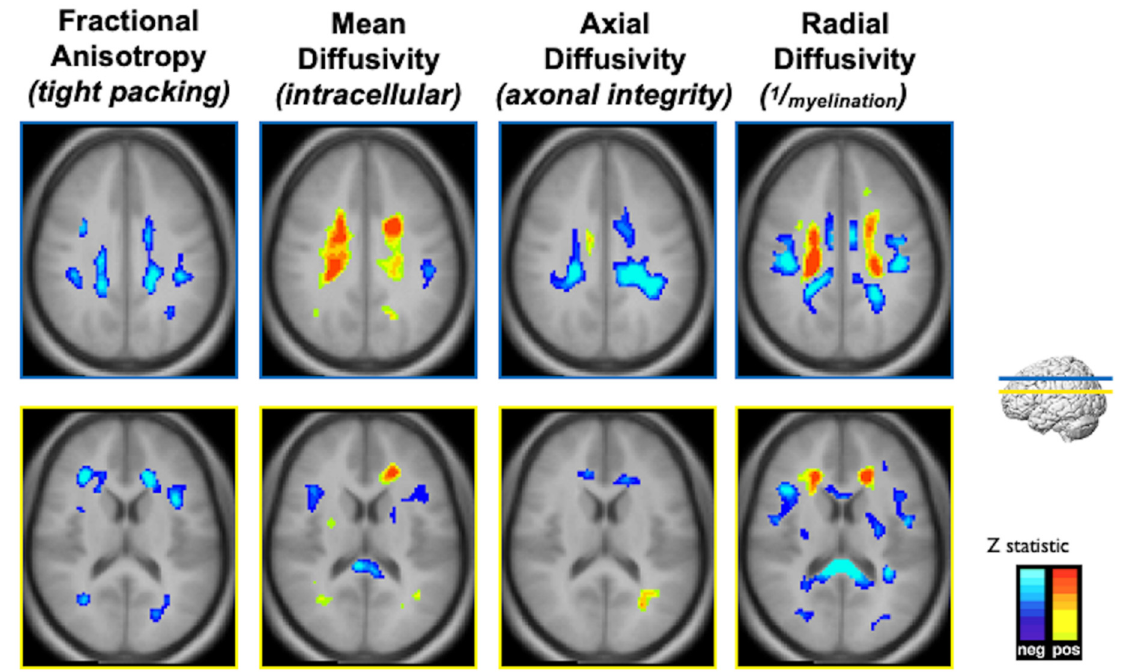
Figure 4. Composite Z-maps showing voxel-wise associations between mean childhood blood lead concentration and fractional anisotropy, mean diffusivity, axial diffusivity and radial diffusivity, respectively, adjusted for significant covariates from left to right for two slice locations, blue at the level of the corona radiata, yellow at the level of the lateral ventricles. The minimum Z statistic was based upon Monte Carlo simulations and corresponds to a two-tailed, corrected voxel-wise p value of <0.05. Blue colors represent inverse associations, yellow-red colors represent direct associations.